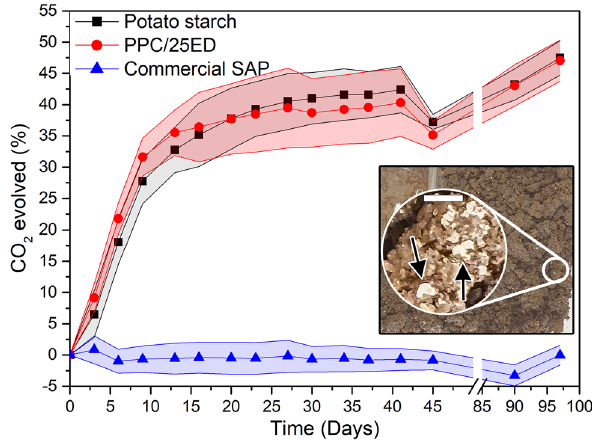
Fig. 5 CO 2 evolved from the samples during the soil degradation test. The inset shows the top of a container with soil and swollen SAP particles after 97 days of testing. The arrows in the inset point at commercial SAP gel particles in the soil after 97 days from the start of the test. The scale bar in the inset represents 2 mm. The coloured areas represent the standard deviation range of the average (solid individual data